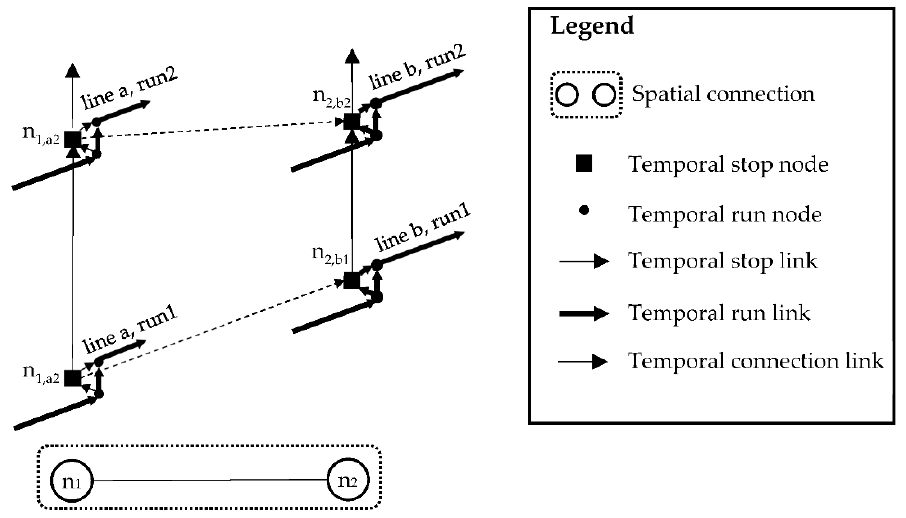
Figure 8. Spatiotemporal connections of an interchange node.